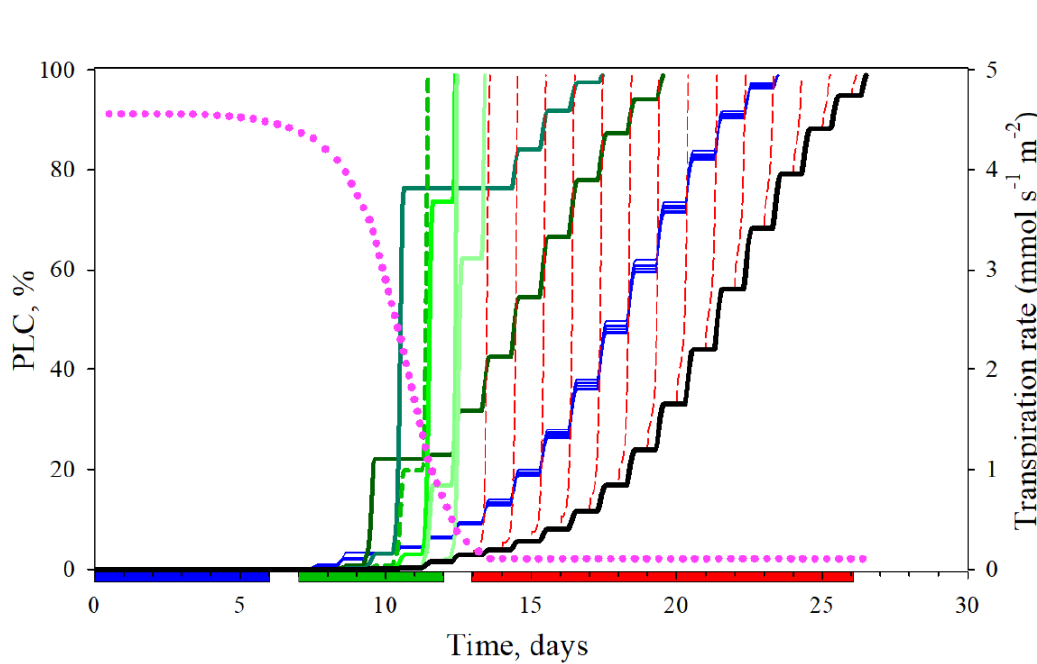
Figure 5. Simulated impacts of a heatwave on xylem embolism for a plant exposed to a water stress at day 0. The time courses of embolism (black line) and transpiration (dotted pink line) are shown for a control plant exposed only to water stress. The other lines show the time courses of embolism for plant exposed to a +15°C heatwave for 3 consecutive days occurring at different times during the drought event: between day 0 and day 6 (blue lines), between day 5 and day12 (green lines), after day 13 (red dashed